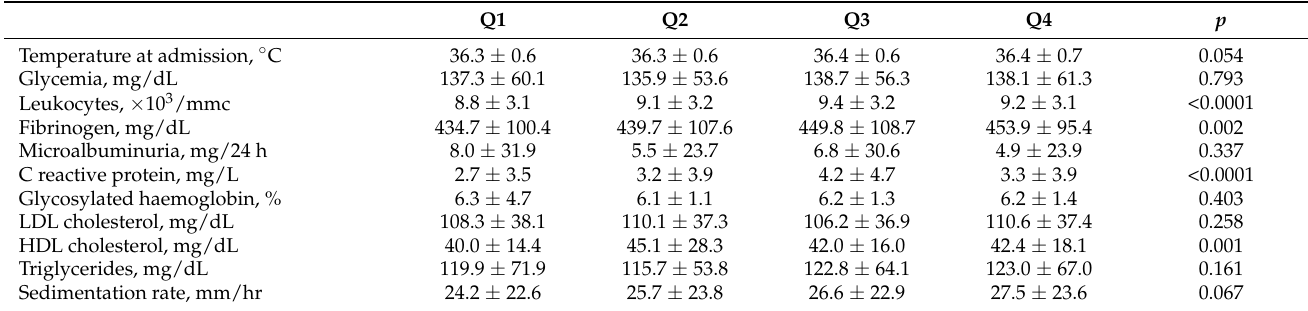
Table 2. Univariate analysis of clinical aspects using latency times as dependent